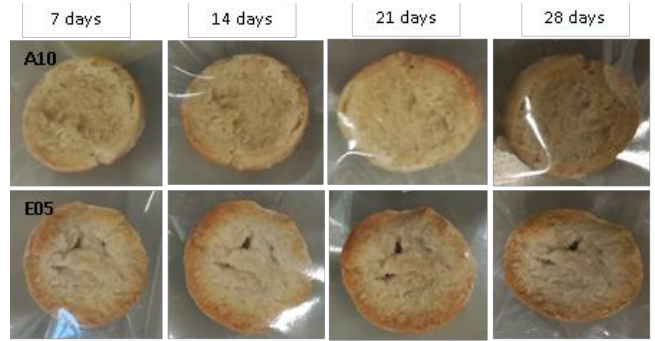
Figure 10. Examples of bread made from sourdoughs inoculated with the dual combination of isolates A10 and E05, and then artificially contaminated with Fusarium culmorum and incubated at room temperature for 7, 14, 21, and 28 days.